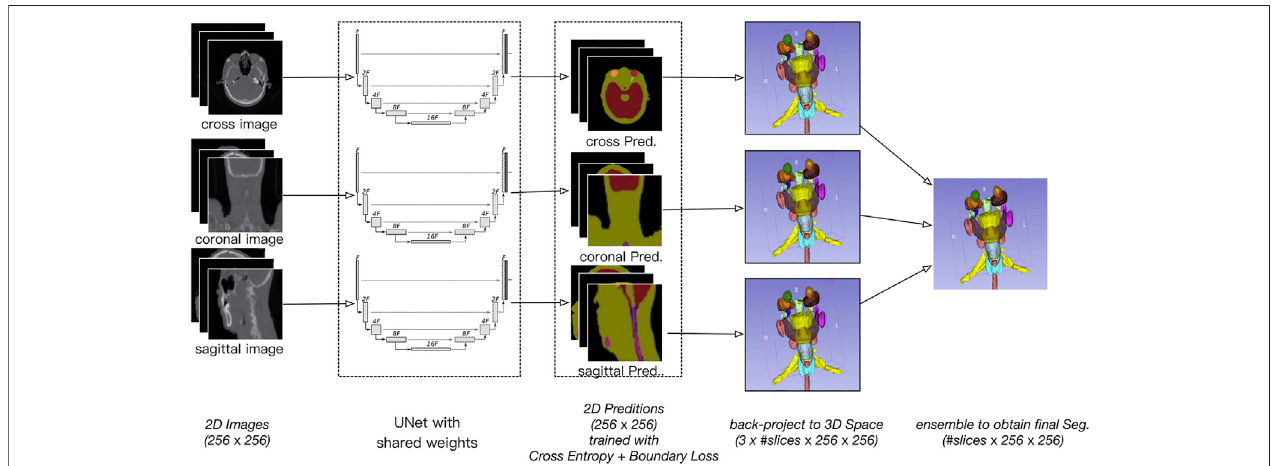
FIGURE 1 | Overview of the proposed SEB-Net, which inputs the three plane 2D images (i.e., coronal, sagittal, and transverse) and outputs the corresponding 2D probabilitymapsofOARs.The2Dprobabilitymapsarebackprojectedtothe3Dspaceandthenaggregatedtoexploitthethreeplanerepresentations.Anovelfeatureof the boundary loss is proposed to train the network so that the organ boundaries are well-predicted.